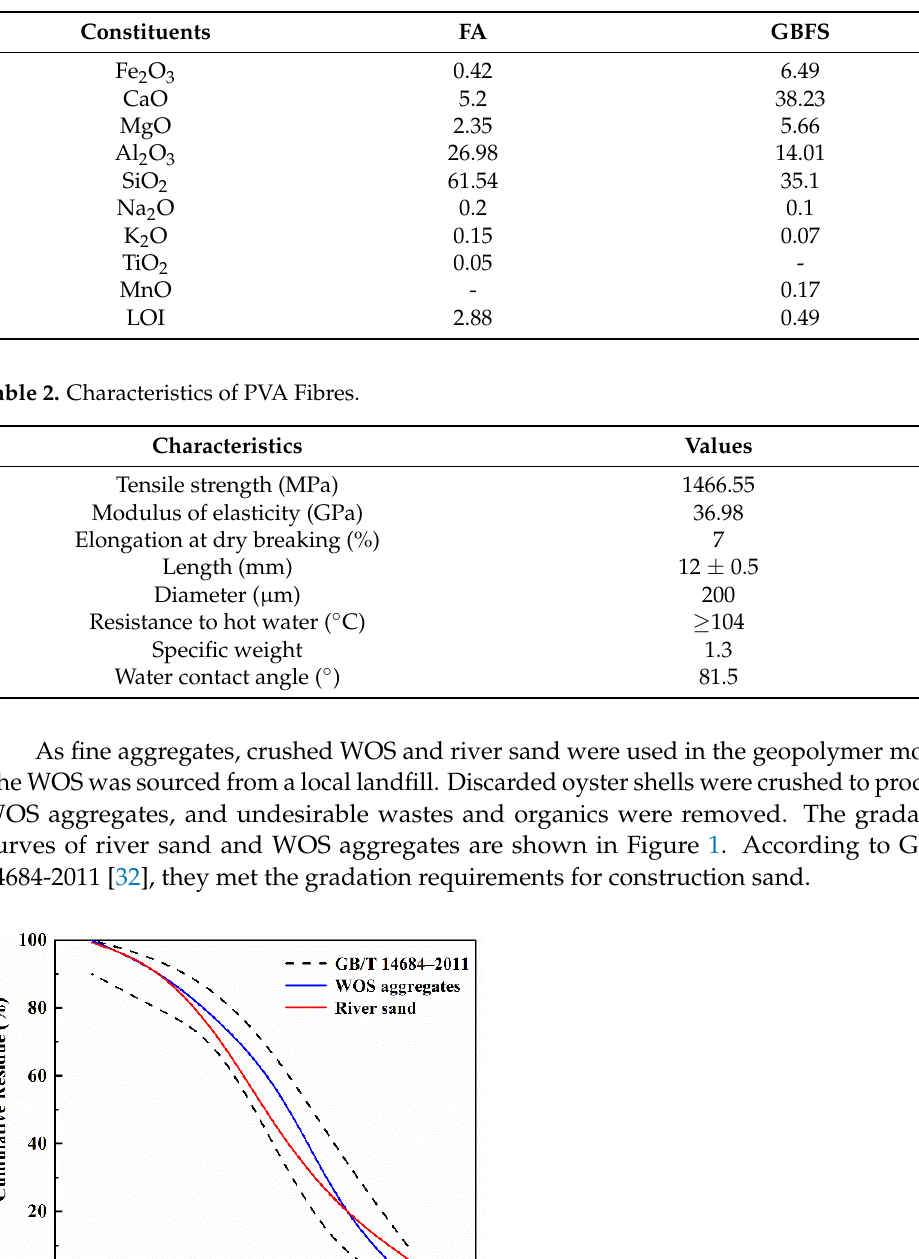
Table 1. Chemical Constituents of FA and GGBFS (wt%).